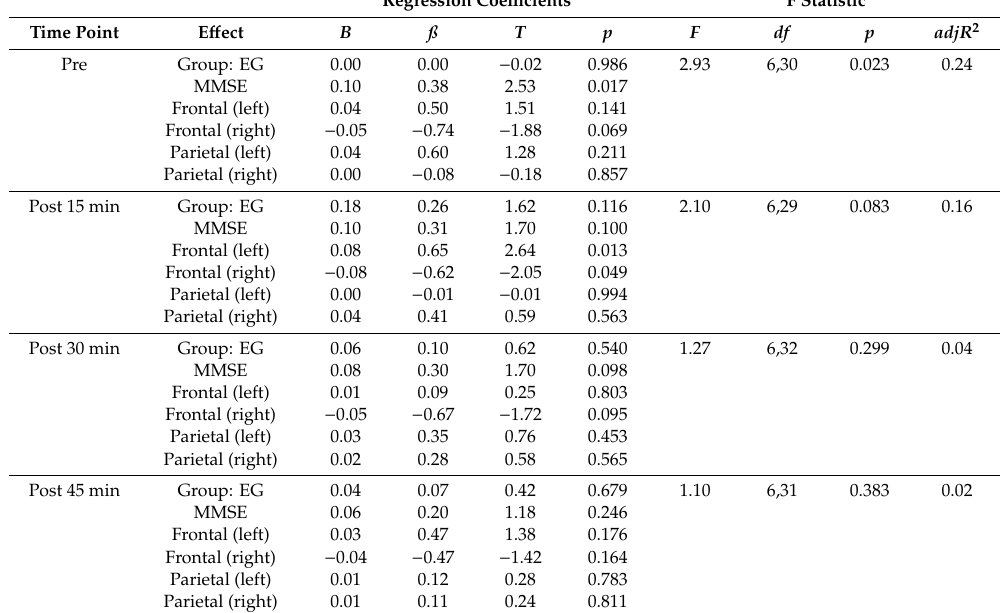
Table 3. Results of the multiple regression analysis with rate-correct score (RCS) as criterion and group, HBdiff for each ROI (frontal left and right, parietal left and right), and MMSE as predictors for each time point.